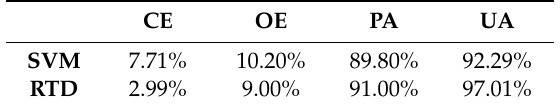
Table 7. The cloud CE, OE, PA, and UA for the SVM and RTD methods for the Liaoning area.